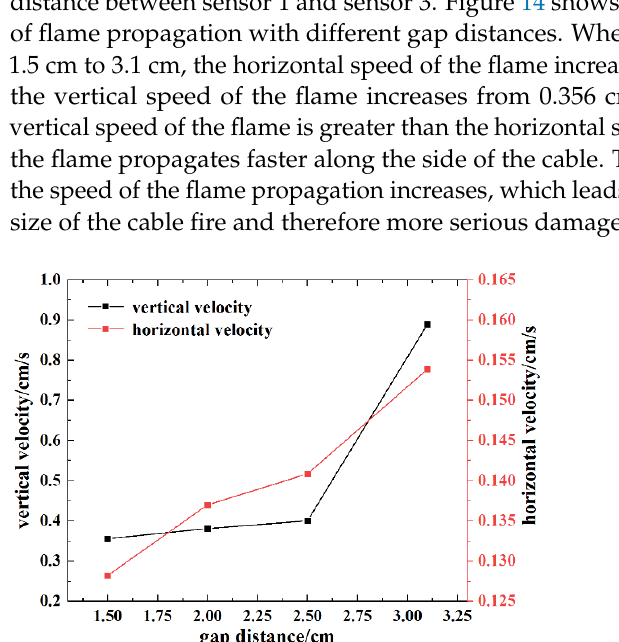
Figure 13. The ignition time and the spread time of cable fire with different gap distances.